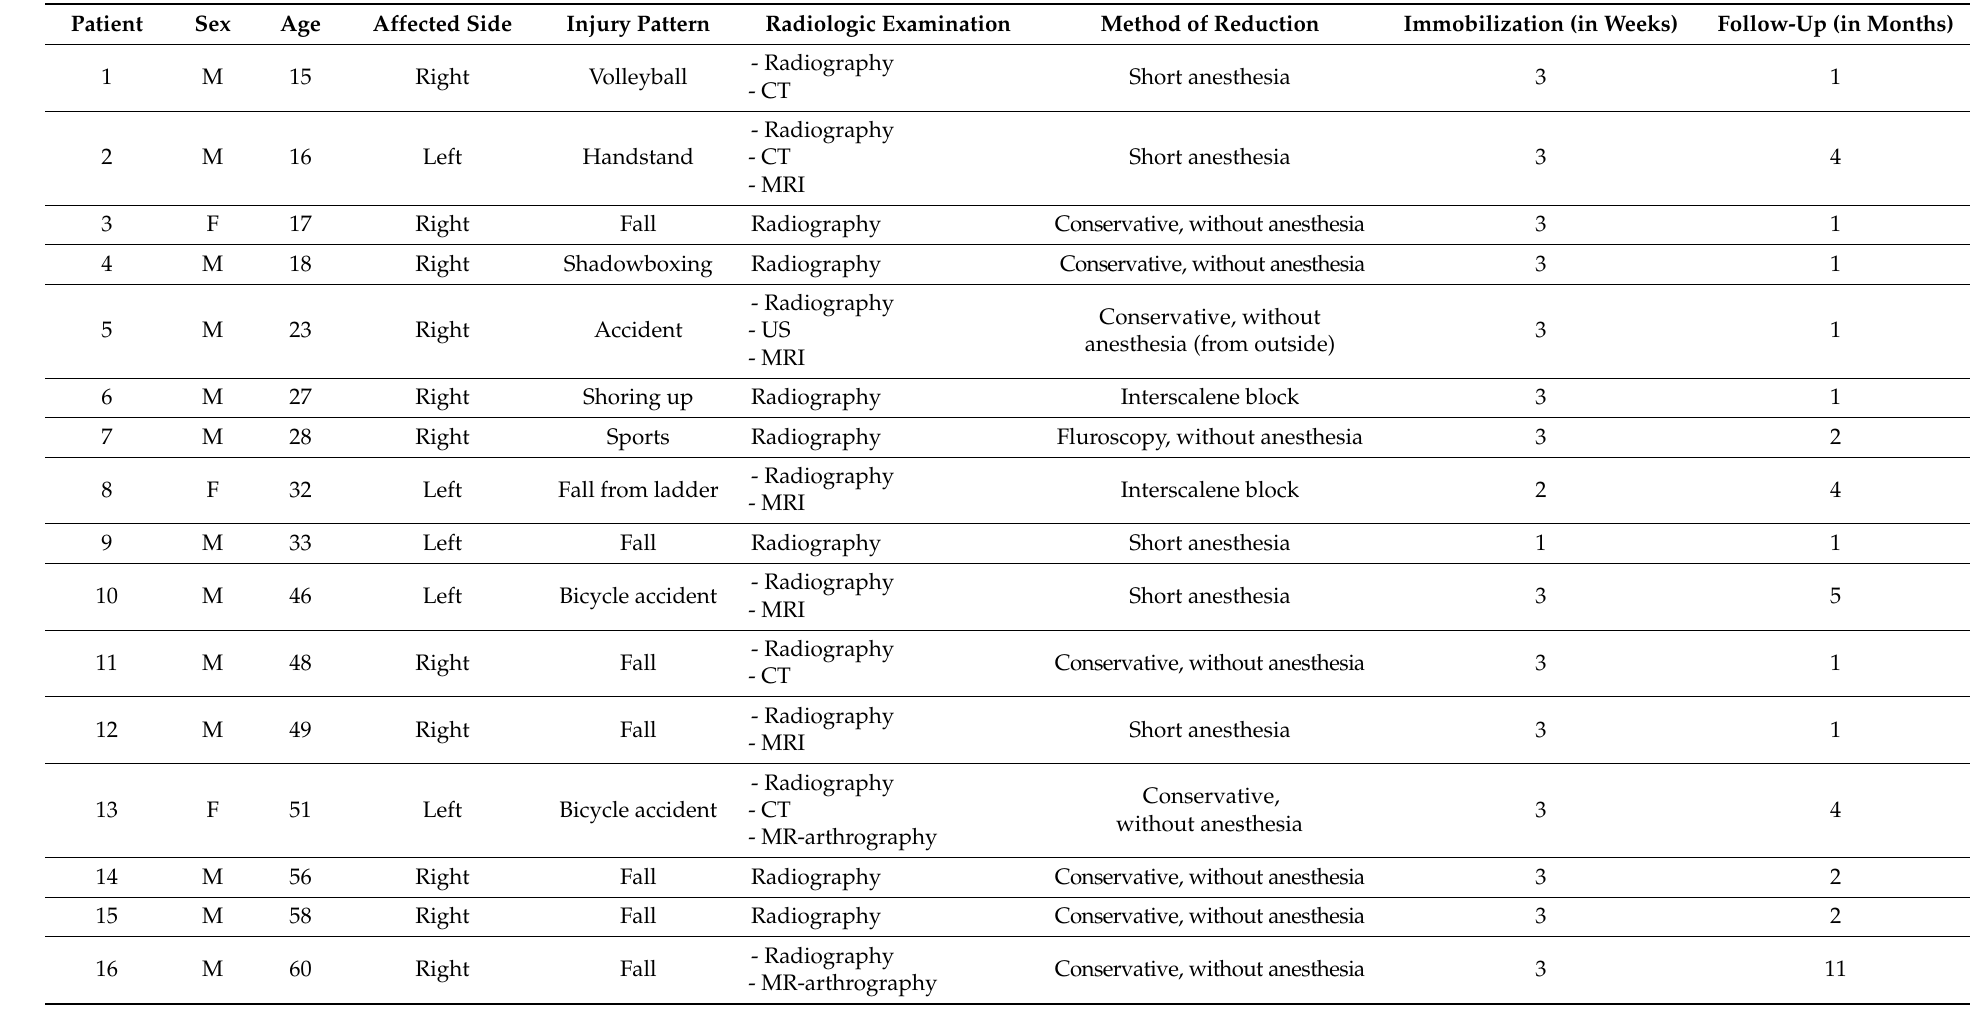
Table 1. Demographic data of included